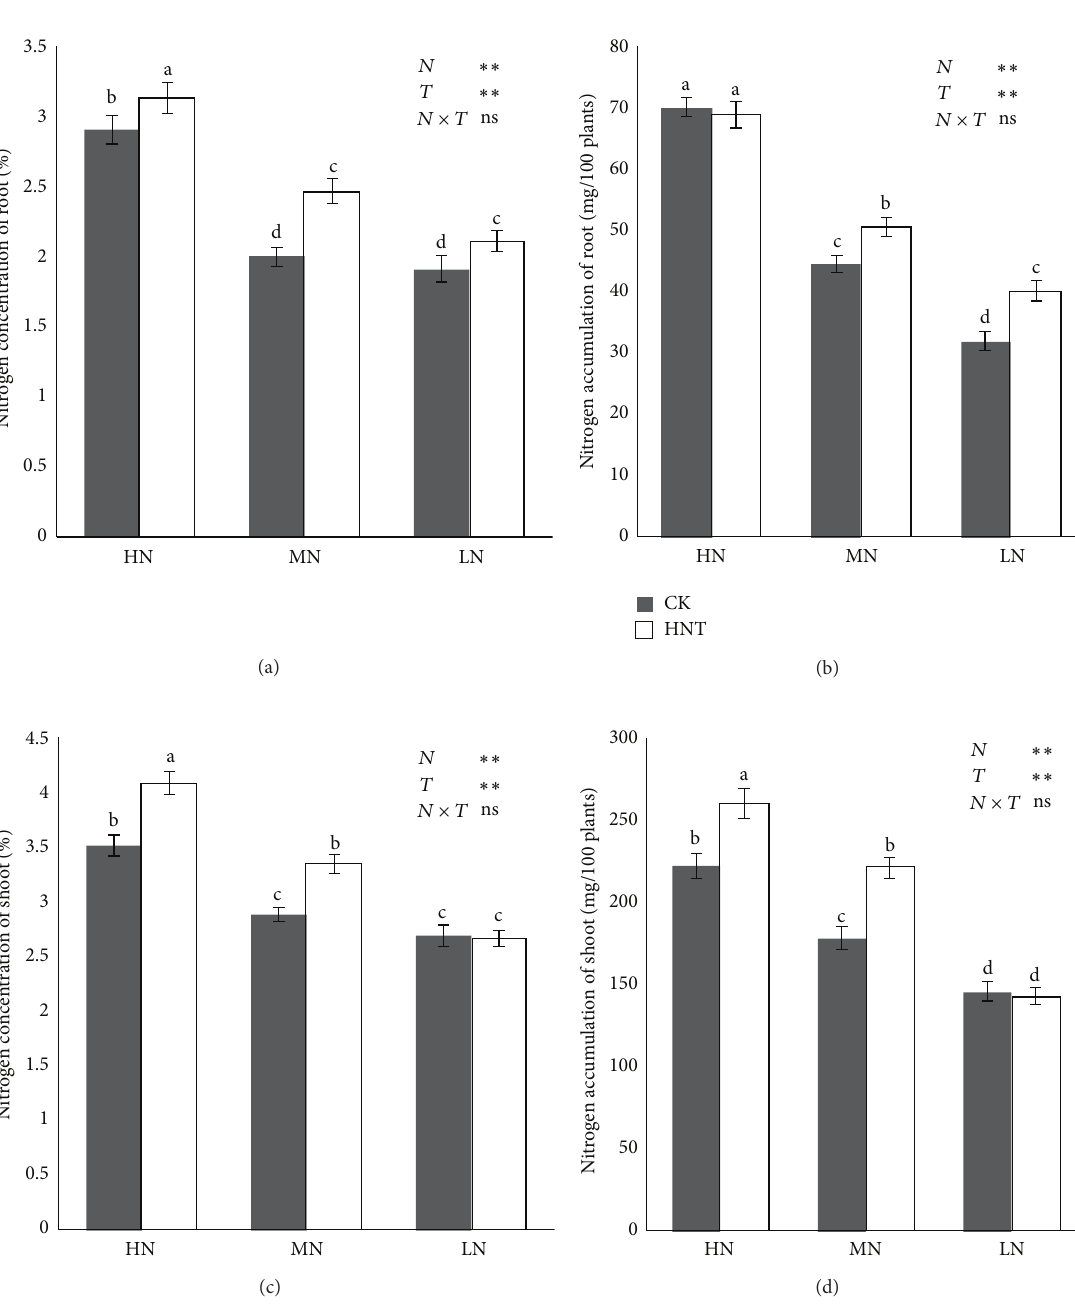
16.7% greater in HNT than in CK at 160 and 40 mg N/L, respectively, but little difference was found at 10 mg N/L. The effect of HNT on nitrogen accumulation and content was similar in root and shoot except that there was no significant difference in root nitrogen accumulation between HNT and CK in the high nitrogen condition (160 mg